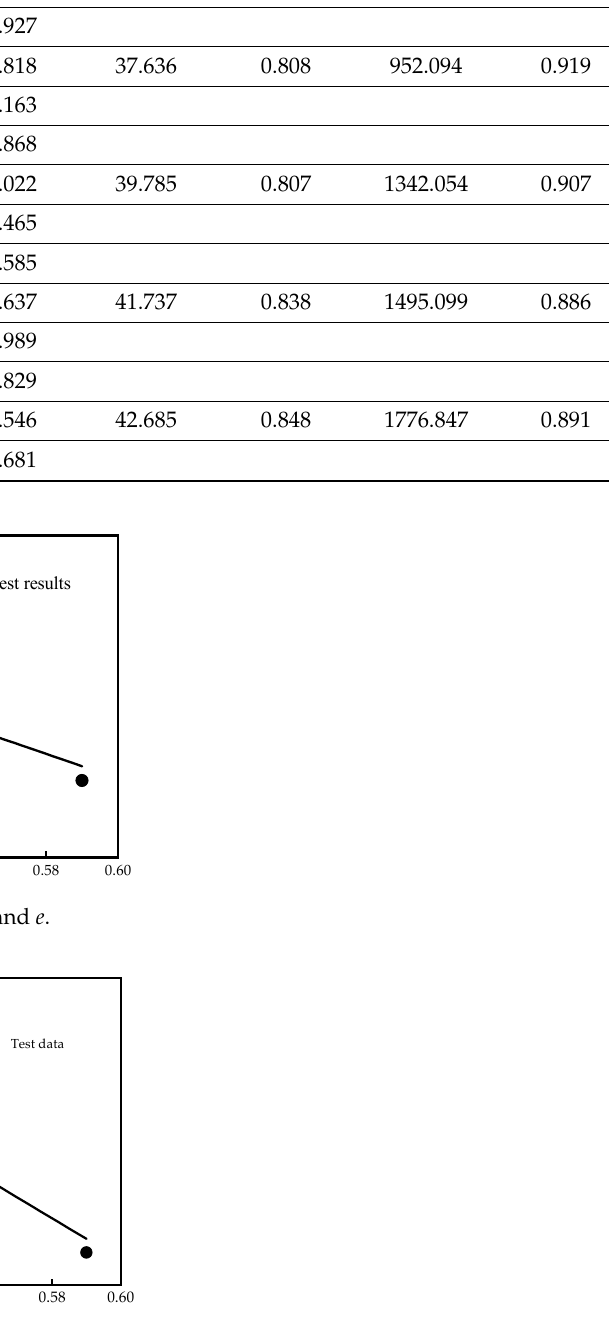
Figure 5. Relationship between φ and e .